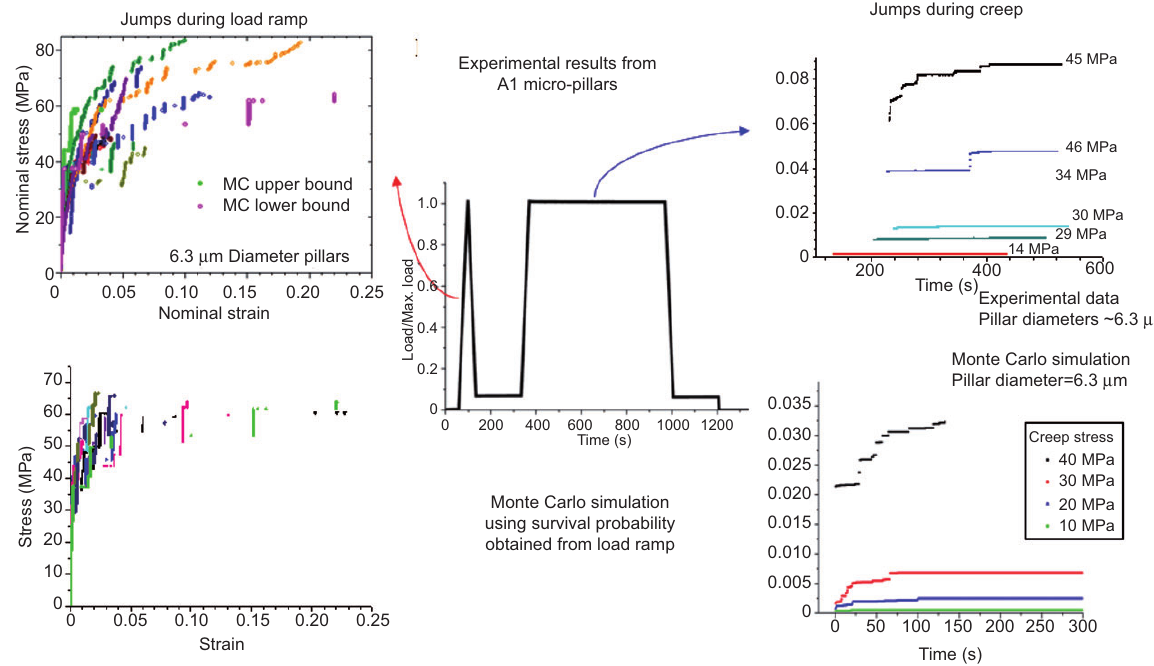
Figure 9 Predicted discrete plasticity vs. experimental observation in compression of aluminum micropillars. Data from ref. [28] .